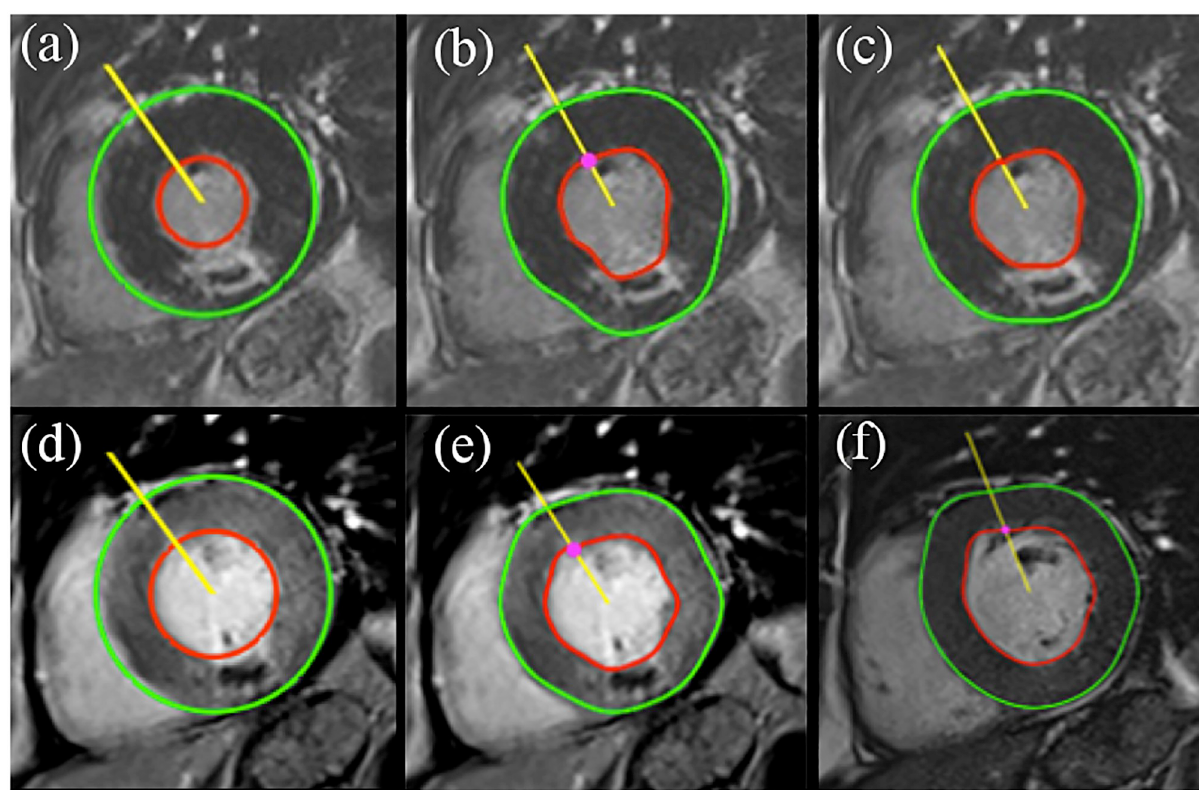
Fig 4. Performance of BEAS segmentation on images with different contrast type. (a) User initialisation on the LGE image; (b) first and (c) second iteration of the automatic segmentation based on (a). (d) User initialisation on the EGE image and (e) segmentation output. (f) Segmentation output on cine bSSFP. All images were taken at the same slice location and from the same patient at different breath-hold scans.